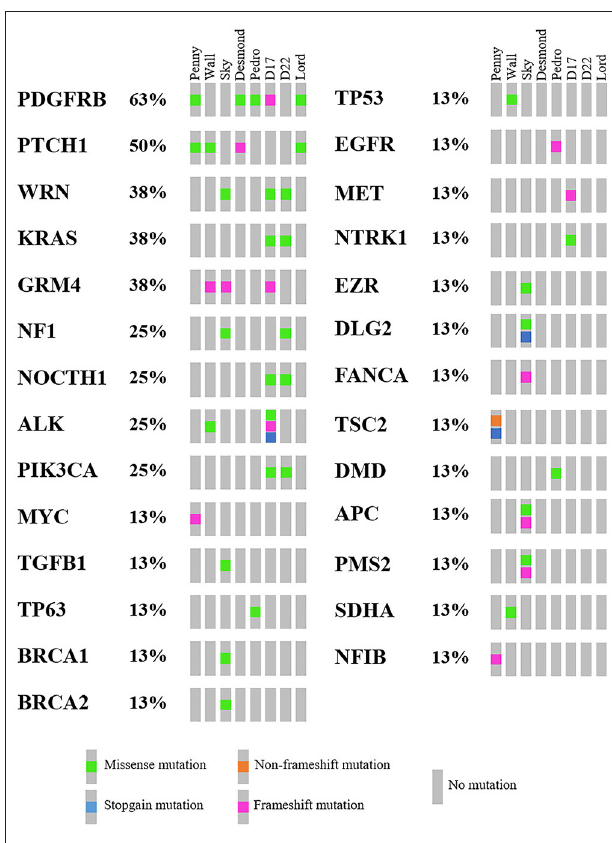
FIGURE 5 | Oncoplot of genes likely involved in canine osteosarcoma pathogenesis retrieved in Level 2 analysis, including the mutational incidence and the mutational type across the cell line